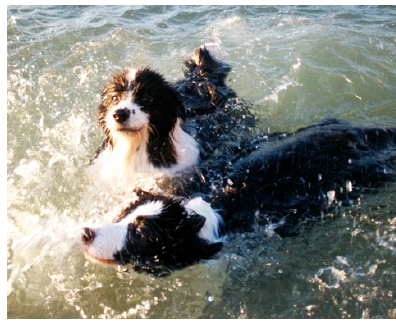
Figure 4. Niuniu goes on a pet tour at the seaside and plays with a companion.